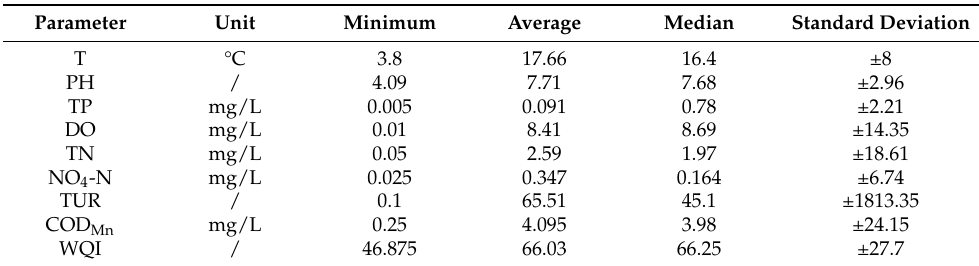
Table 4. Daily monitoring data of water quality variables in Chaohu Lake and descriptive statistics of WQI during